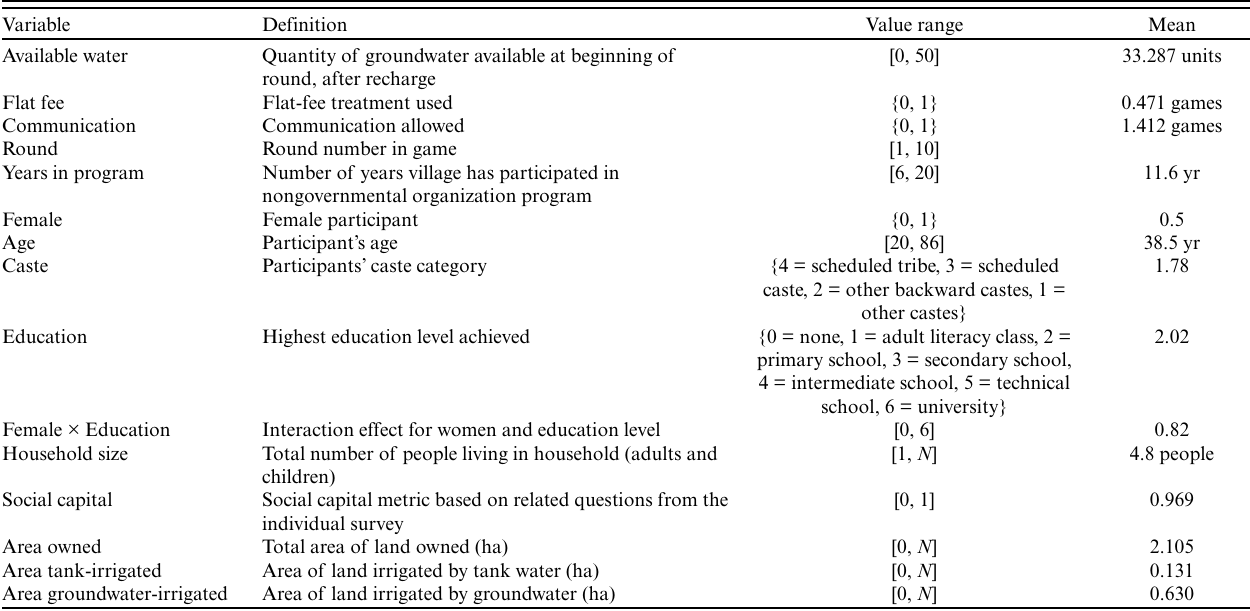
Table 1. Definition and summary of the independent variables used in the analysis. Values in square brackets give ranges of continuous variables; values in curvy brackets are possible values of categorical